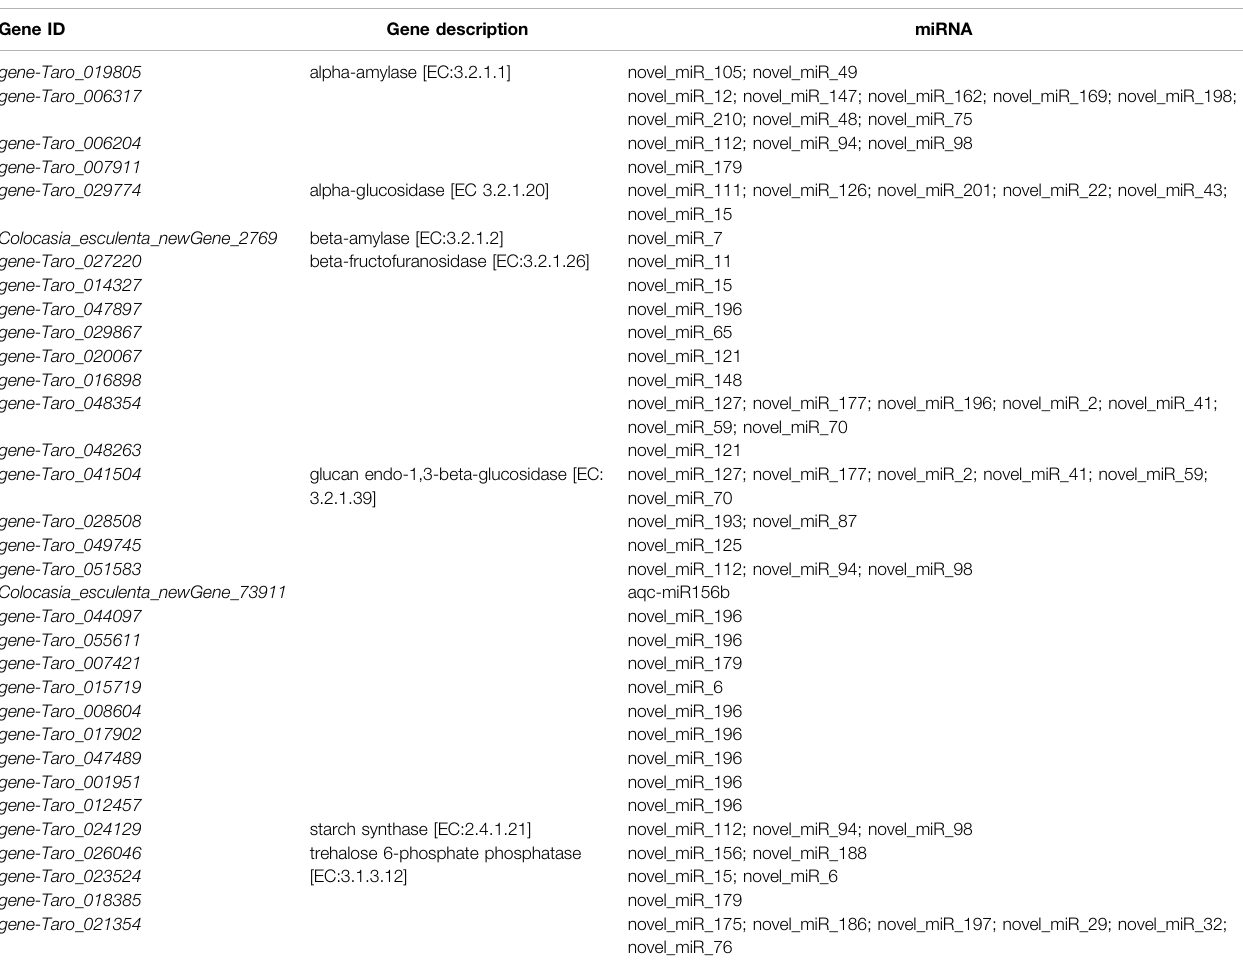
TABLE 2 | List of genes and associated miRNAs that were enriched in starch and sucrose metabolism